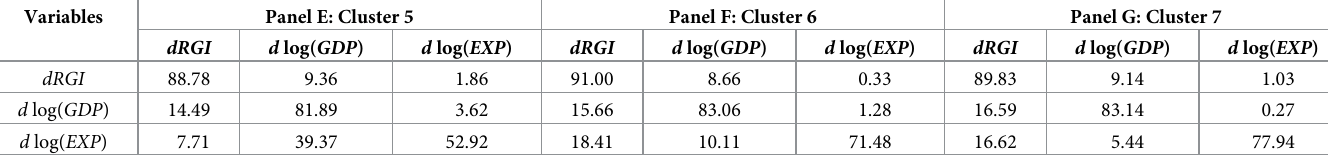
Table 12. Variance decomposition results under different industry groups (unit: